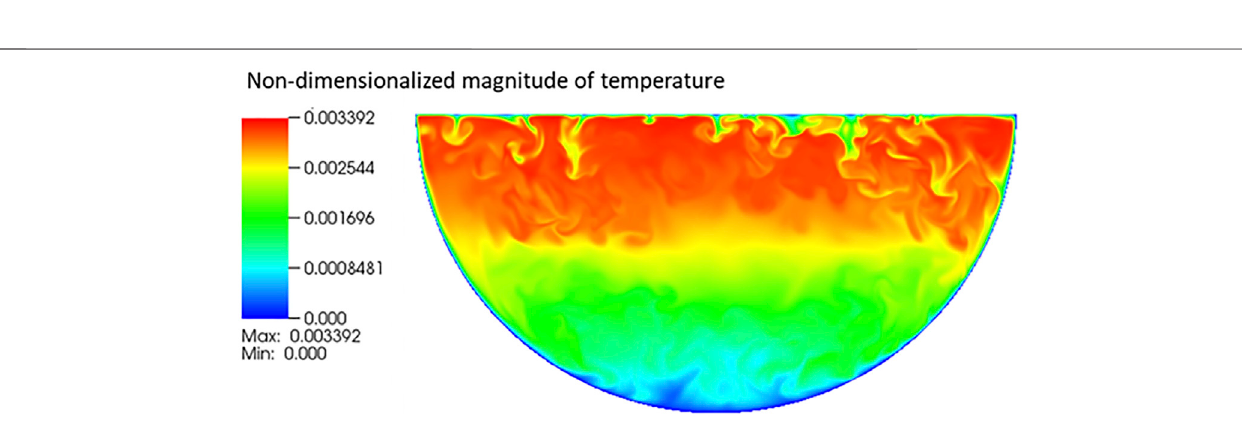
FIGURE 2 | Instantaneous distribution of the magnitude of the velocity of an internally heated natural convection with Ra = 10 11 (Bian et al., 2022).